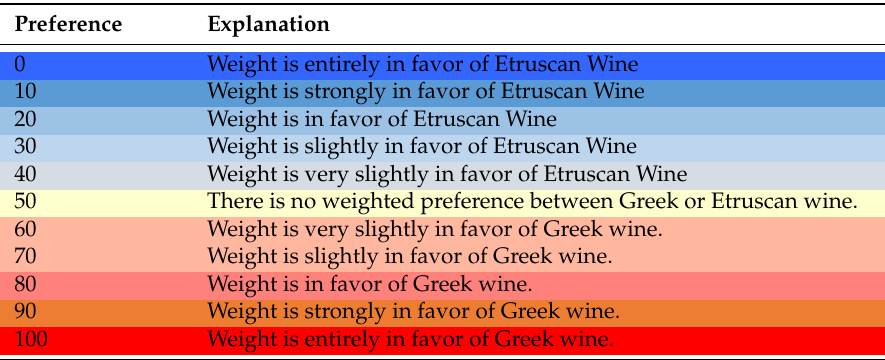
Table 4. Preference Values swept across in this